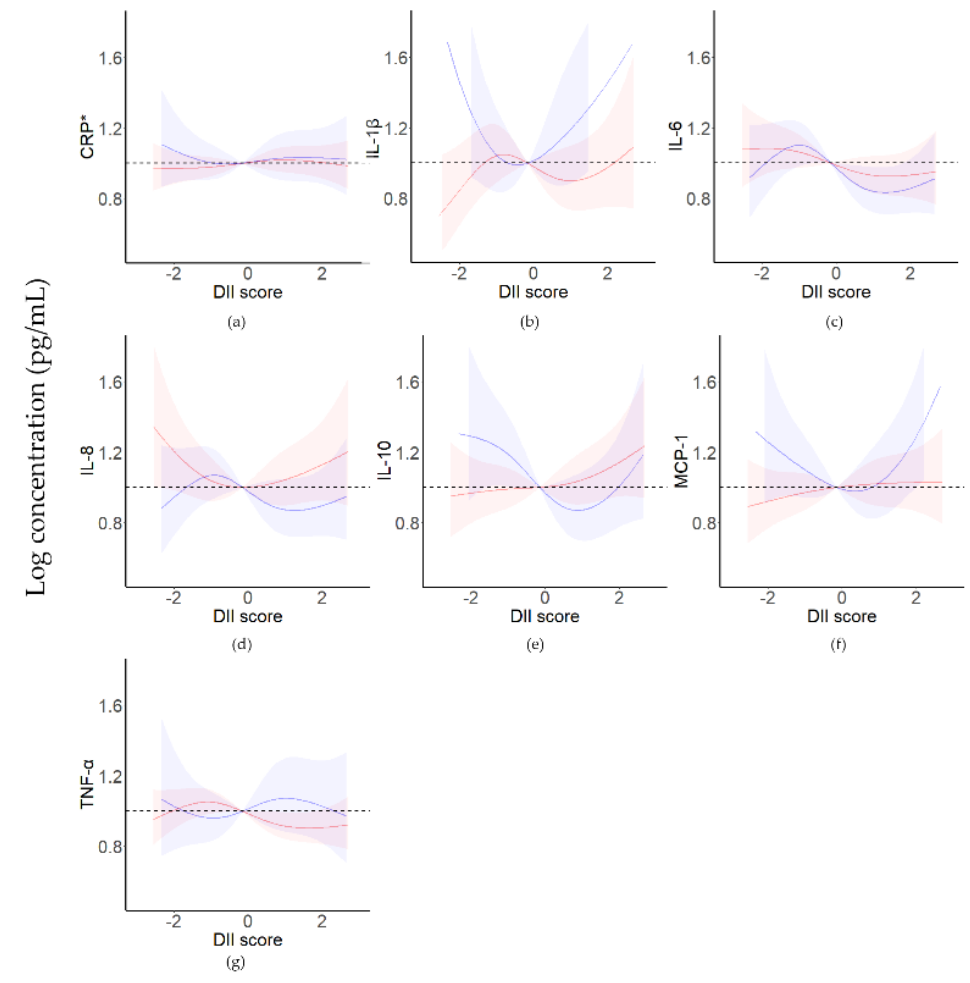
Figure 2. Restrictive cubic spline analysis of cytokine levels and DII scores for pregnant women in the second and third trimesters. The red line represents pregnant women in the second trimester ( n = 159); the blue line represents pregnant women in the third trimester ( n = 90). CRP, C − reactive protein; IL, interleukin; MCP − 1, monocyte chemoattractant protein − 1; TNF − α , tumor necrosis factor − α . ( a ) CRP, ( b ) IL − 1 β , ( c ) IL − 6, ( d ) IL − 8, ( e ) IL − 10, ( f ) MCP − 1, ( g ) TNF − α . Energy intake, age, education level, annual household income, and BMI were used as covariates. * CRP level is the logarithm of the cytokine level (ng/mL).